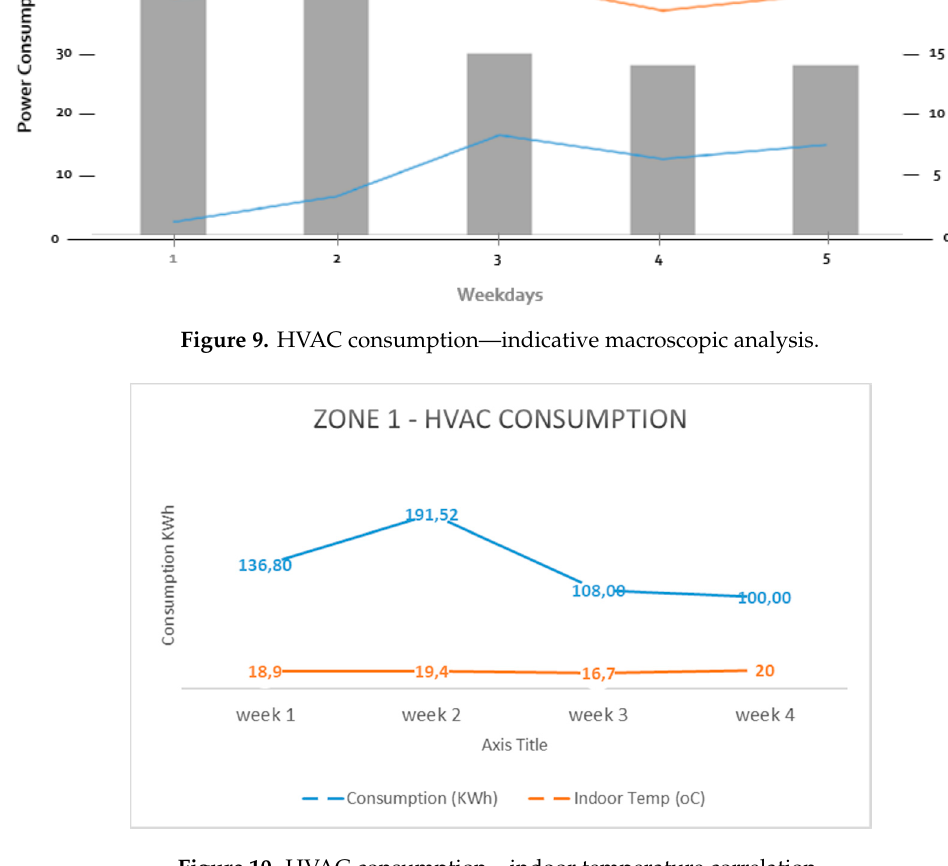
Figure 10. HVAC consumption—indoor temperature correlation.